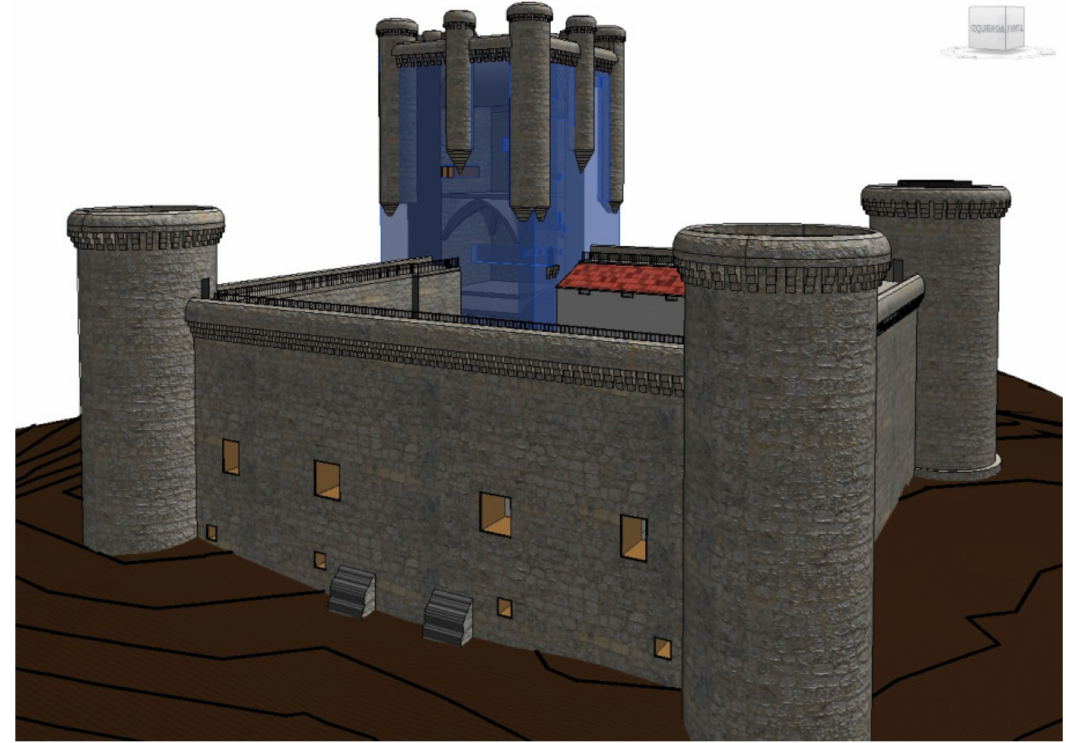
Figure 5. H-BIM parametrical modeling of the Castle of Torrelobat ó